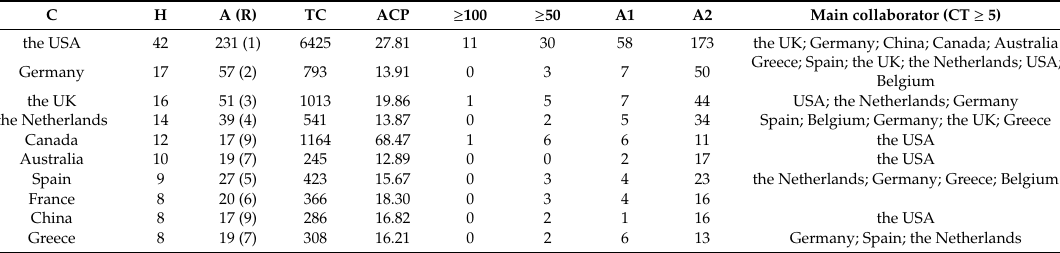
Table 6. Distribution of articles by country /